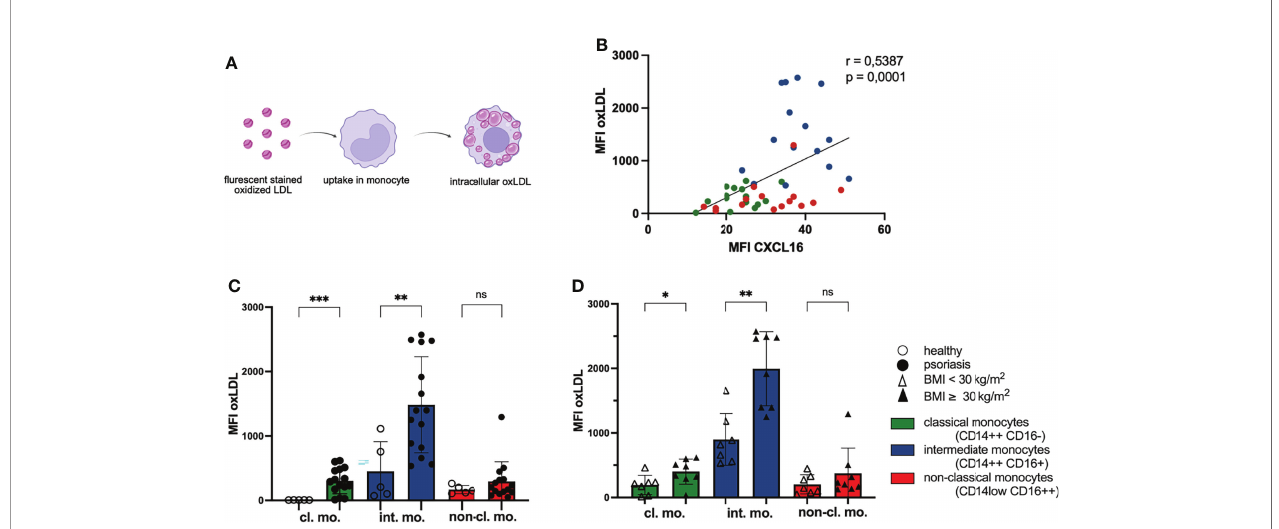
FIGURE 2 | Phagocytosis of oxLDL by monocytes increases with CXCL16 expression. (A) PBMC were incubated with red fl uorescing oxLDL for 3 h and subsequently stained for CD14, CD16 and CXCL16 expression. (B) The mean fl uorescence intensity (MFI) of CXCL16 and oxLDL is shown. Every psoriasis patient is represented by three dots (n= 15). Colors represent monocyte subsets as de fi ned in Figure 1A , Spearman correlation. (C) oxLDL concentrations in monocytes subsets of healthy controls (un fi lled dots; n=5) and patients with psoriasis ( fi lled dots; n=15), mean and SD, unpaired t test. (D) intracellular oxLDL concentrations in monocytes of normal-weight psoriatic patients (un fi lled triangles; n=7) and obese patients ( fi lled triangles; n=8), mean and SD, unpaired t test. *p < 0.05; **p < 0.01; ***p < 0.001. ns, not signi fi